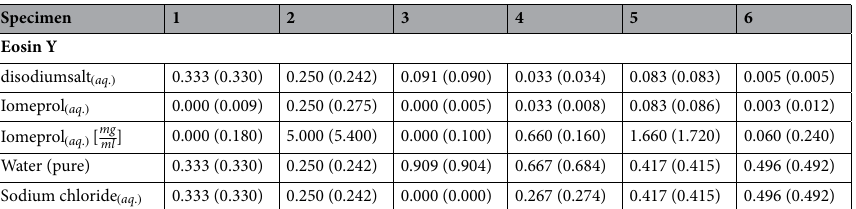
Table 1. Volume fractions to which the algorithm should converge as well as the fractions in parentheses for which the algorithm found the optimum. The corresponding concentration is also given for the volume fraction of iomeprol and the optimization for samples 2, 4 and 5 is shown visually in Fig.2d.